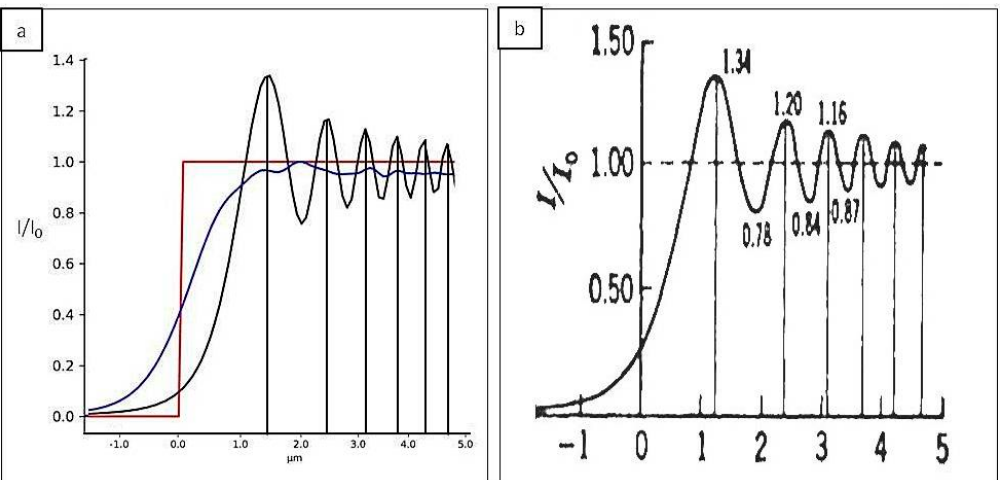
Figure 3. Di ff raction pattern from a plane wave incident to a sharp edge in the case of coherent and incoherent illumination. ( a ) Result from the simulation for N = 5 (black line) and N = 100 (blue line). ( b ) Theoretical result for coherent